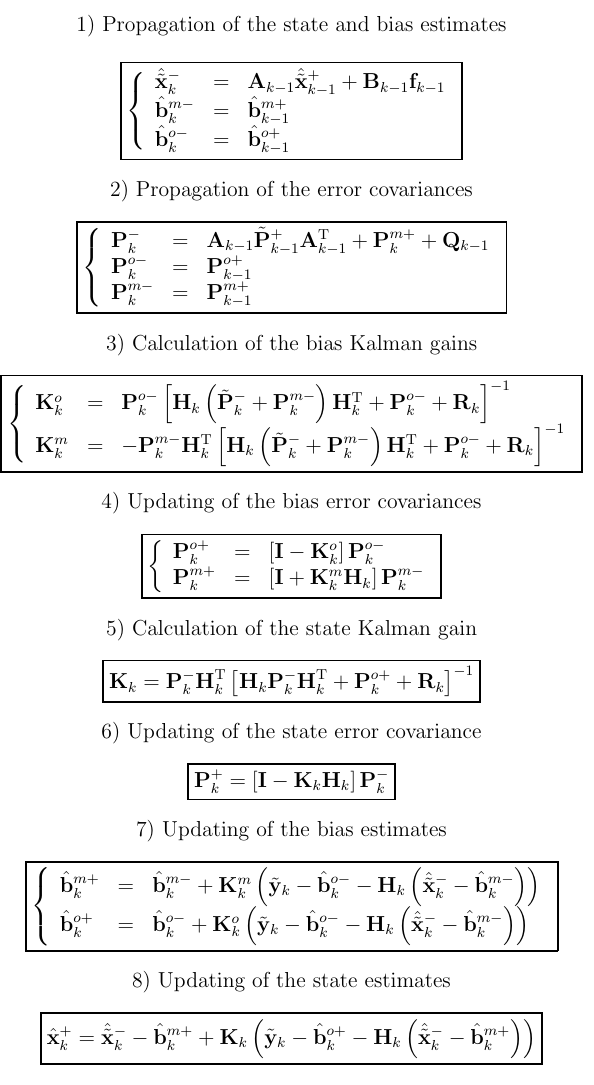
Fig. 1. Schematic of the methodology for a discrete Kalman filter.